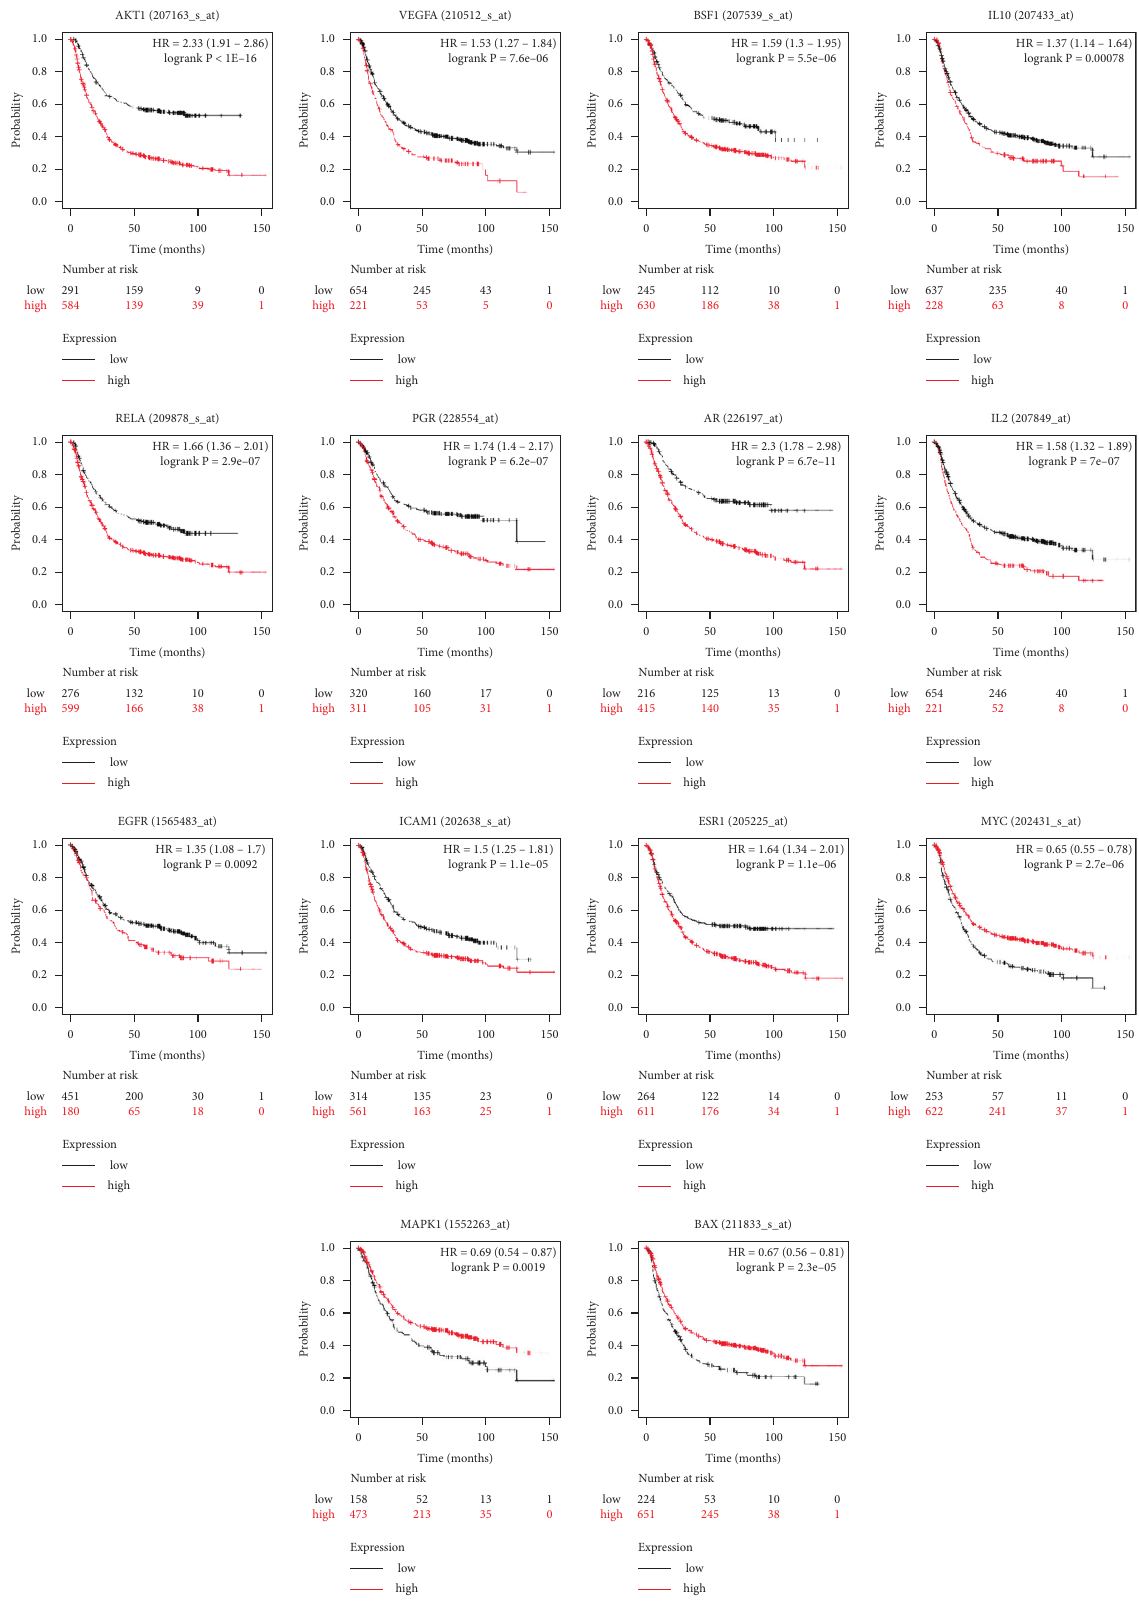
Figure 6: Survival analysis of the core target